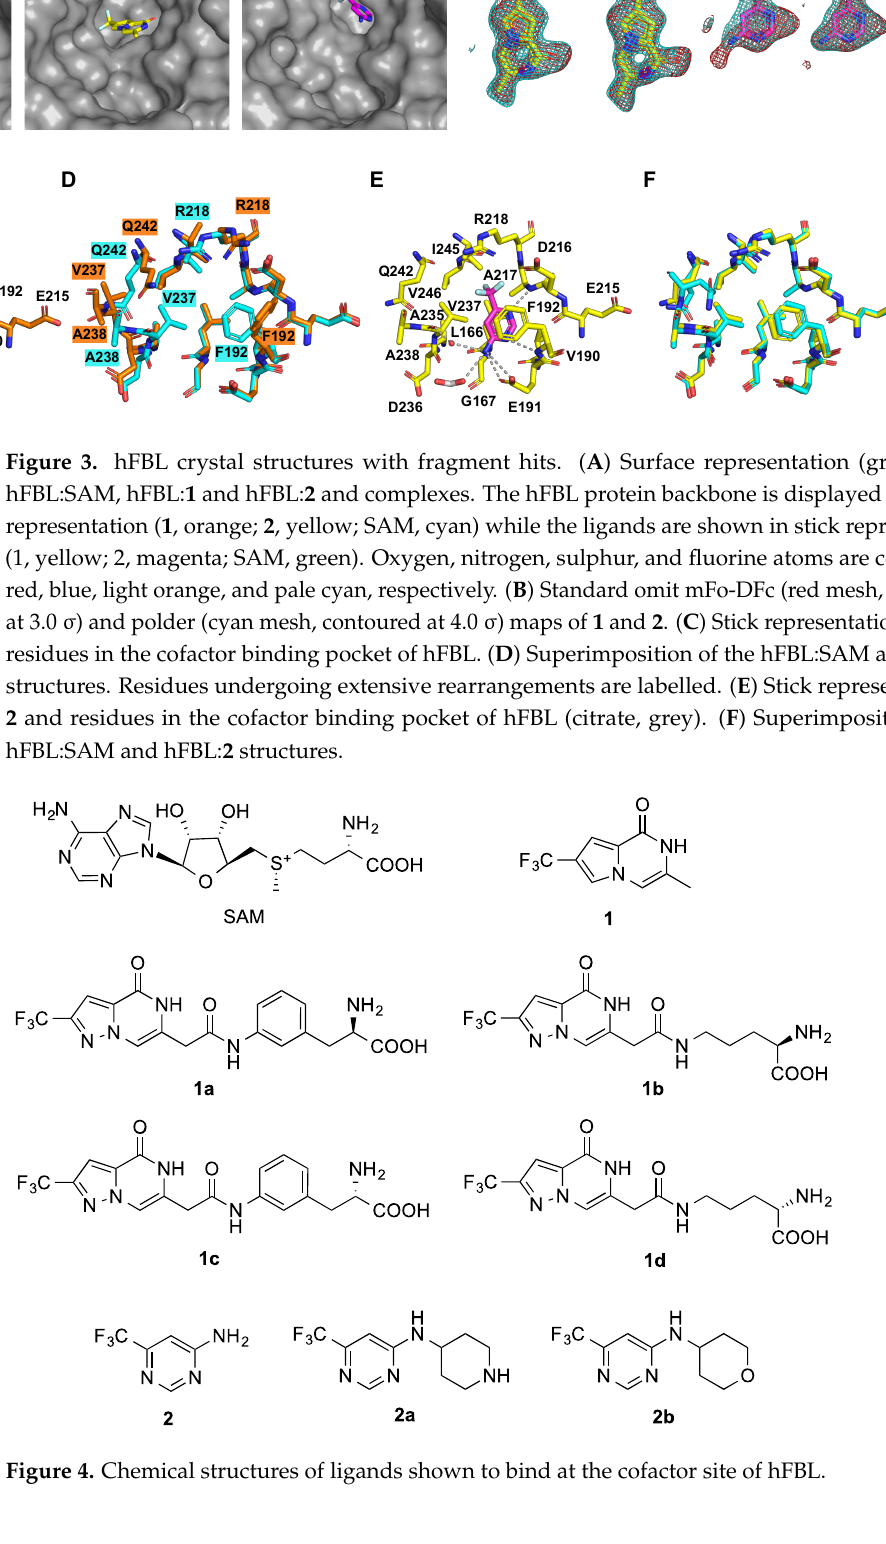
Figure 5. STD NMR spectra showing competitive binding between cofactor SAM and fragment hits 1 and 2 , respectively, with hFBL. ( A ) STD NMR spectra showing the binding of 0.5 mM 1 to 35 µM hFBL in the absence (bottom expansion) and presence (top expansion) of 0.5 mM SAM, with 1024 scans and 2s saturation time. ( B ) STD NMR spectra showing the binding of 1 mM 2 to 40 µM hFBL in the absence (bottom expansion) and presence (top expansion) of 0.1 mM SAM, with 512 scans and 3 s saturation time. In 19 F NMR detected screening, 9 fragment hits were identified. STD NMR competi- tion assays revealed that five of these compounds are SAM competitive binders, as their STD NMR signals decreased in the presence of SAM (Supplemental Figure S5). However, none of these NMR hits could be detected by X-ray crystallography when soaked individ- ually with hFBL crystals.2.4. Details of the Binding Modes of Compounds 1 and 2. Compound 1 binds to the adenosine region of the hFBL cofactor binding site by an induced fit mechanism, which involves a significant rearrangement in the loop connecting the β 4 strand and α 5 helix (Figure 3A,C,D). The compound induces a significant shift of the protein backbone around D236-Q242 resulting in extensive movement of the side chains of V237 (5.9 Å) and Q242 (5.2 Å). The movement of the side chain of V237, which forms a hydrophobic interaction with the adenine moiety of SAM in hFBL SAM , results in displacement of the side chain of Q242 from a buried to a solvent exposed position, and exposure of a new hydrophobic pocket (L166, A235, V237, I245, and V246) that accommo- dates the trifluoromethyl group of the compound (Figure 3A,C,D). Compound 1 also forms hydrogen bonds with the side chain carboxylate of E191, the backbone nitrogen of F192, and a water molecule that interacts with the backbone nitrogen of A217 and the backbone carbonyl of E216. 7.007.107.207.307.407.507.607.707.807.908.00 f1 (ppm) 6.6.86.97.07.17.27.37.47.57.67.77.87.98.08.18.28.38.48.58.68.78.88.99.09.1 f1 (ppm)